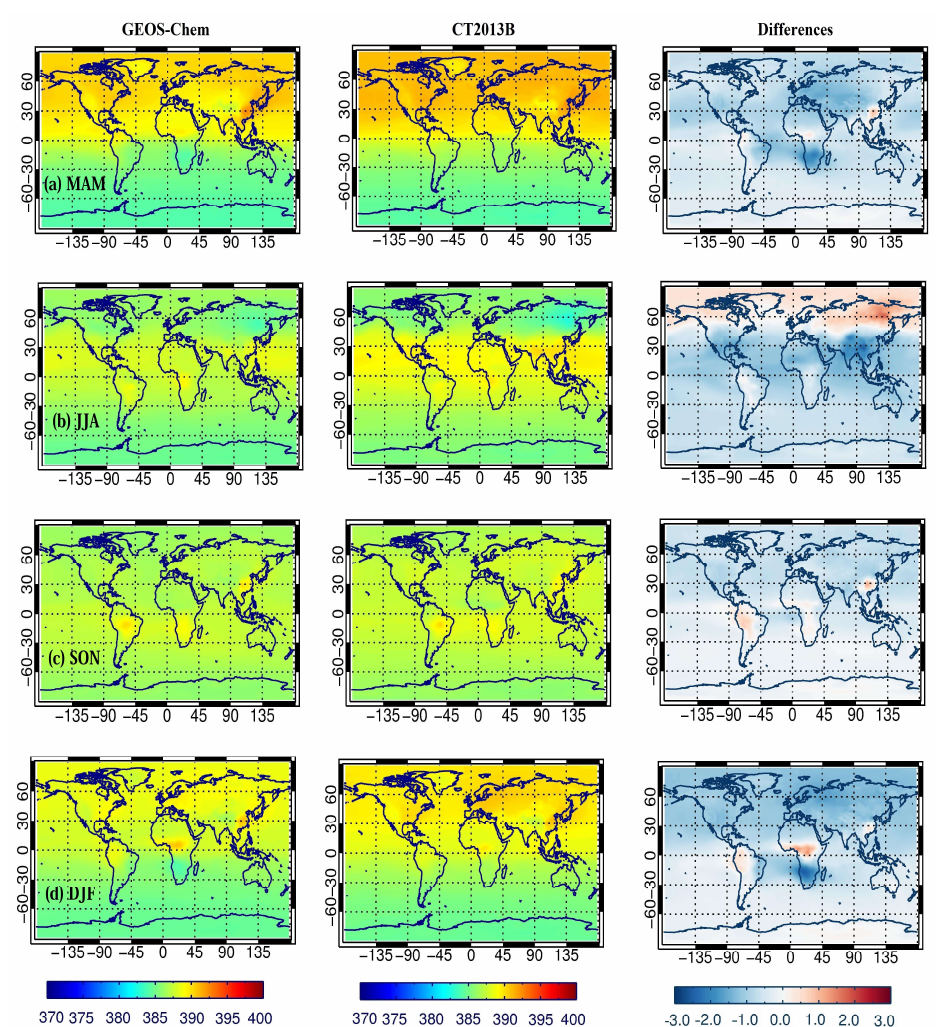
Figure 5. Comparison of global XCO 2 simulated with GEOS-Chem and CT2013B during March 2010– February 2011. Seasonal averaged XCO 2 concentrations are shown for GEOS-Chem, CT2013B and their difference (GEOS-Chem − CT2013B). ( a ) MAM; ( b ) JJA; ( c ): SON; ( d ): DJF. Unit: ppm.